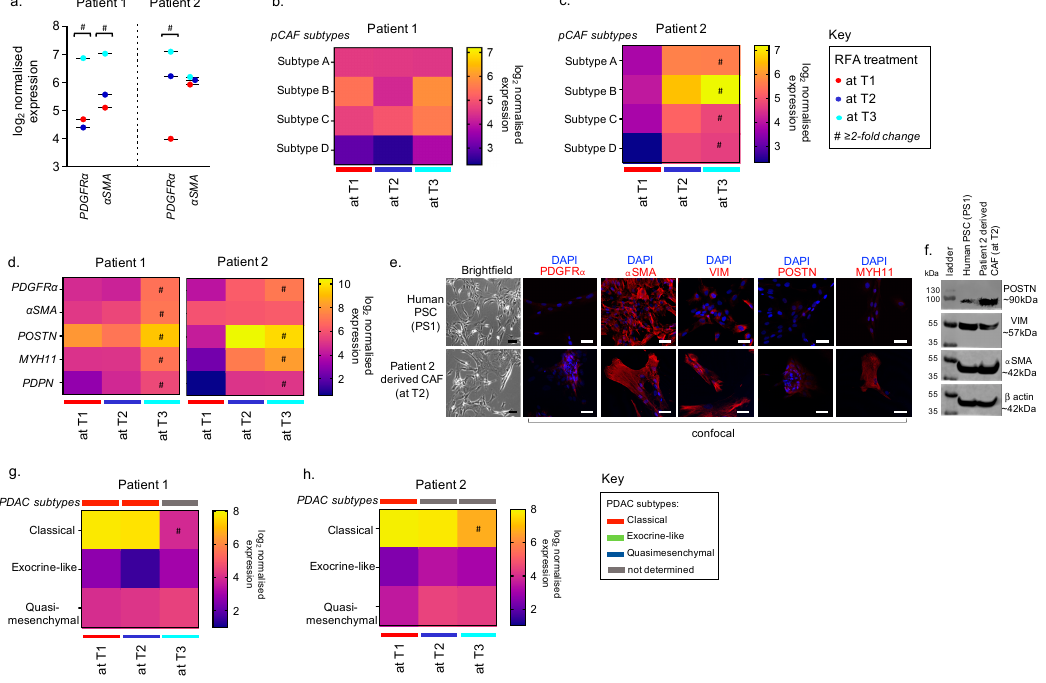
Figure 2. Longitudinal FNAB from RFA-treated patients and TME. ( a ) Dot plot showing upregulation of pan-CAF markers- PDGFR α and ACTA2 ( α SMA ) as a response to RFA in patient 1 and 2, respectively. ( b , c ) Heatmaps representing a switch in the CAF subtypes over the course of RFA in patient 1 and 2, respectively; separate scale bars for the two patients depicting averaged log 2 nor- malised subtype-specific CAF gene expression. ( d ) Heatmap representing change in IHC validated exclusive pCAF subtype-specific genes over the course of RFA in patient 1 and 2. ( e ) Brightfield (10x magnification on Leica DMi8; scale bar represents 100 μ m) and confocal (20× magnification on Zeiss LSM700; scale bar represents 50 μ m) images of different CAF markers in patient 2 T2-derived CAFs and normal (immortalised) human pancreatic stellate cells, PS1. ( f ) Western blot showing expression of different CAF markers in patient 2 T2-derived CAFs and normal (immortalised) human pancre- atic stellate cells, PS1. ( g , h ) Heatmaps representing a switch in the PDAC subtypes over the course of RFA in patient 1 and 2, respectively; colour bars represent NTP-derived PDAC subtype and sep- arate scale bars for the two patients depicting averaged log 2 normalised gene expression associated with each PDAC subtype. # represents greater than or equal to two-fold change in gene expression between T1 and T3. 3.3. Feasibility of Using FNABs to Study Cancer Subtypes in RFA-Treated PDACs Our data indicated that both patients at baseline were categorised into the classical PDAC subtype. RFA led to a marked decrease in genes representing the classical PDAC subtype in both patients at T3 compared to baseline and T2 (Figure 2g,h). No particular change in the exocrine-like or quasi-mesenchymal PDAC subtype was observed in either of the patients upon RFA. 4. Summary This feasibility study established the value of longitudinal sampling with EUS- FNABs to study local TME changes occurring in response to RFA in two patients. We successfully isolated RNA and cultured CAFs from these biopsies to comprehensively profile immune, CAF and cancer cell gene expression using a custom panel of genes asso- ciated with PDAC subtypes (both cancer and CAF) and immune cell types. In this case study, we have attempted to elucidate immune modulation in response to RFA in two